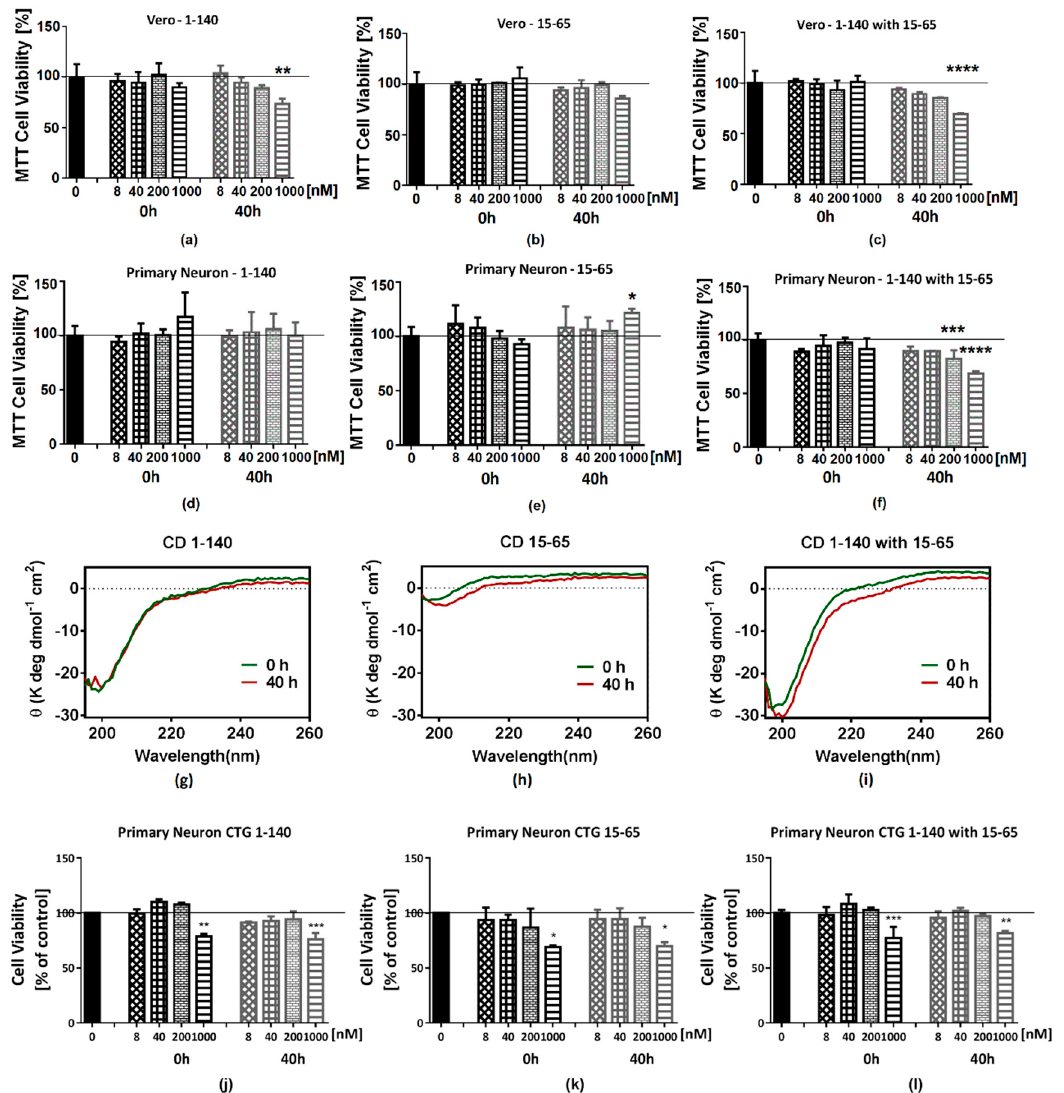
Figure 8. Comparative cytotoxicity of Hu-syn15-65 and full-length Hu- α syn obtained by MTT assay and CellTiter-glo assay, after 24 h of exposure using Vero cells and primary neuron cells. Full-length Hu- α syn, α -syn 15-65 and a co-incubation of the two were aggregated at a 100 uM concentration for 0 h or 40 h at 37 °C using an orbital incubator. ( a – c ) Cell viability result of vero cells using MTT assay. ( d – f ) Cell viability result of primary neuron cells using MTT assay. ( g – i ) Secondary structure changes between incubation times of the samples monitored by Circular Dichroism (CD). ( j – l ) Cell viability result of primary neuronal cells using CellTiter-Glo assay. In the MTT assay, α -syn 15-65 showed no toxicity in monomeric or oligomeric forms under 1000 nM after 40 h of aggregation time. However, the toxicity of the aggregated full-length α -syn increased in 1000 nM when incubated with α -syn 15-65. α -syn fragment 15-65 could increase the toxicity of the α -syn oligomer. In the CellTiter-Glo assay, it is indicated that at 1 uM of α -syn 15-65, this fragment could decrease neuron cell ATP